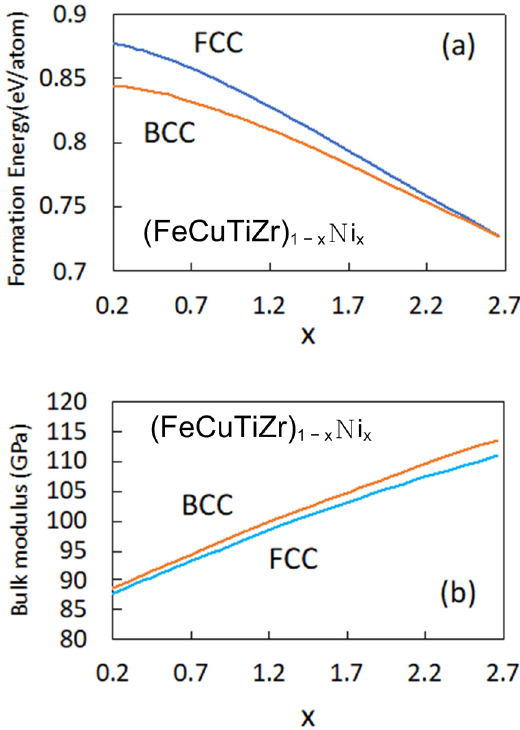
Figure 6. The dependence on Ni content of ( a ) the formation energies and ( b ) the bulk modulus of the FCC and BCC phases.